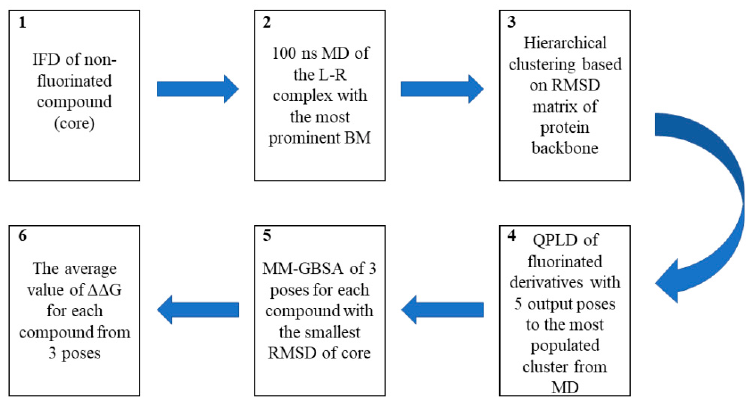
Figure 4. Computational workflow used to predict the most potent fluorine derivative. The workflow began with the IFD of a nonfluorinated compound (core) ( 1 ) followed by 100 ns-long MD simulations ( 2 ), which were then clustered based on the RMSD matrix of the protein backbone ( 3 ). All derivatives were docked to the three most frequently observed conformations of the protein using the QPLD algorithm ( 4 ). Using the MM-GBSA approach, the binding energy ( Δ G) was calculated for the three conformations of the ligand with the smallest RMSD of the core to nonfluorinated compounds ( 5 ). Finally, the difference in the interaction energy between the most active compound and subsequent isomers ( ΔΔ G) was calculated ( 6 ).